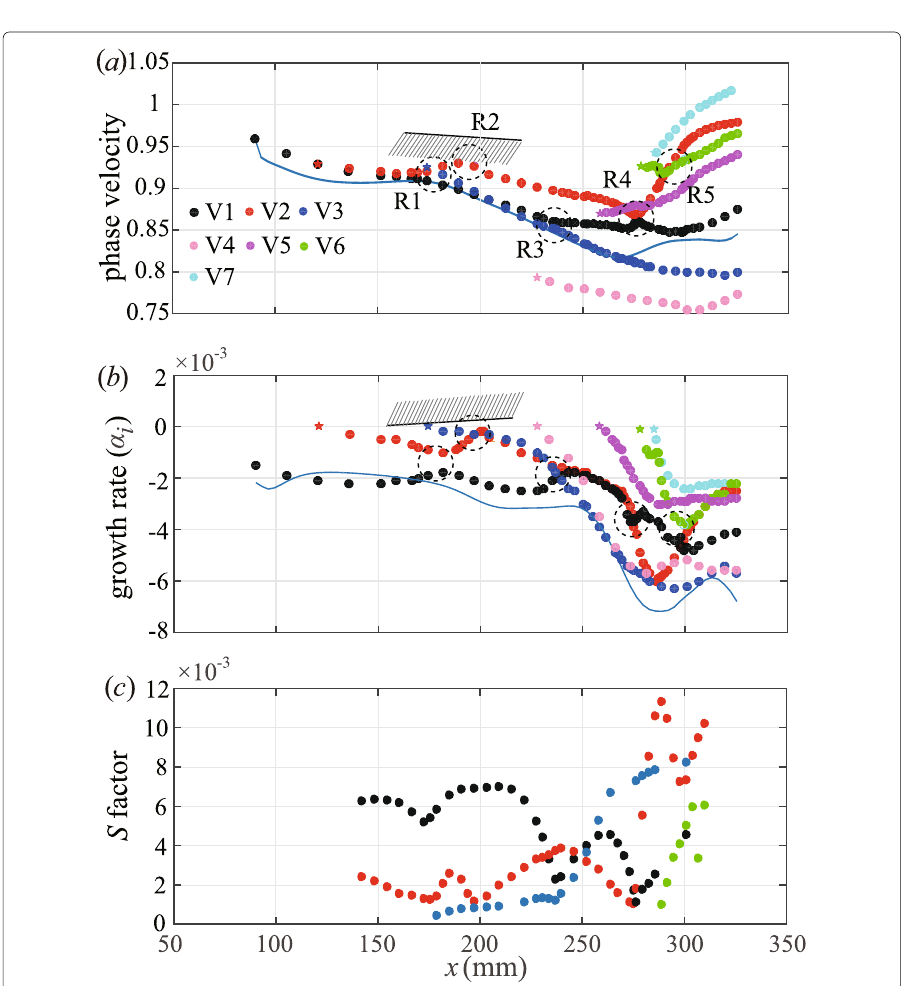
Fig. 3 BiGlobal results showing traces of different varicose modes with frequency of 135 kHz, ( a ) phase velocities, ( b ) growth rates and ( c ) S factor. The star, (cid:11) , depicts the neutral location where the mode becomes unstable. The solid line represents the PSE3D results initiated by mode V1. Mode synchronization regions are indicated by dashed circles. The black line denotes the continuous spectrum and the grey region depicts the nearby stable